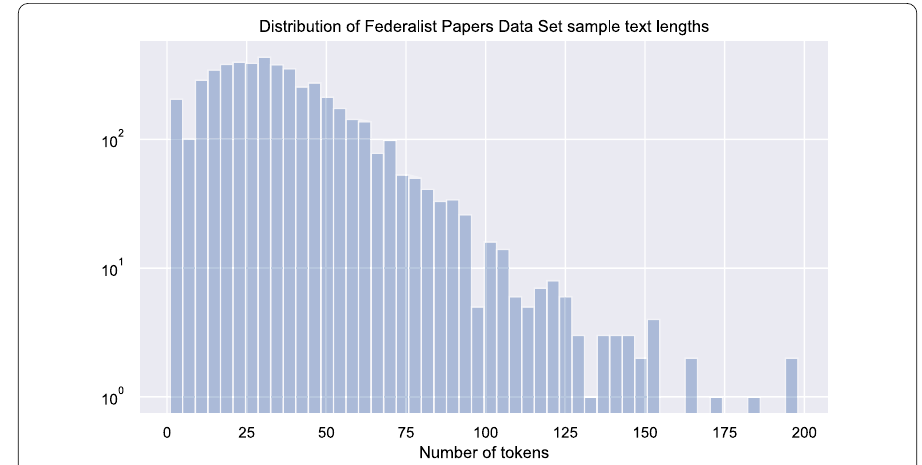
Figure 2 Distribution of the sample text lengths in the Federalist Papers Data Set for papers with known authors. Average = 35.9 tokens, median = 32 tokens, 0.75 quantile = 47 tokens, 0.95 quantile = 78 tokens